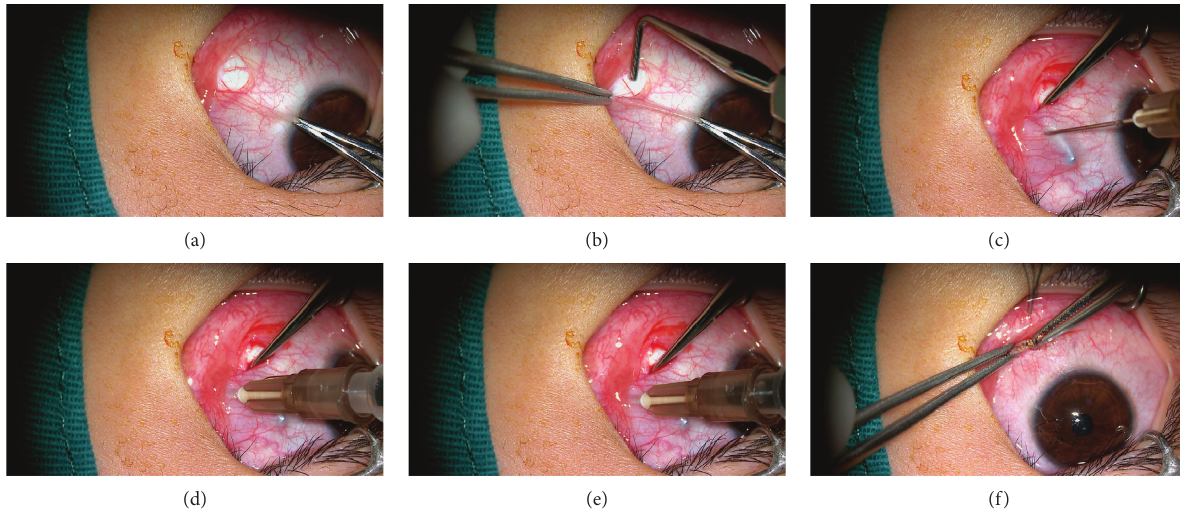
Figure 1: Procedures of conjunctival microincision injection of botulinum